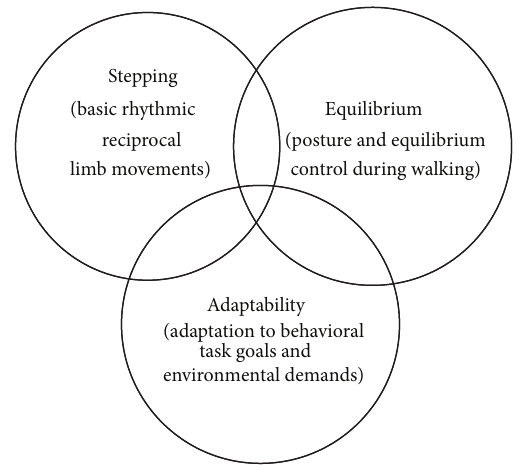
Figure 1: Neural control model of functional walking. Neural control of walking can be explained as a tripartite model consisting of stepping, equilibrium, and adaptability [11, 14]. All three are necessary for optimal walking function. This review focuses on walking adaptability, which is defined as the ability to adjust walking to behavioral task goals and environmental